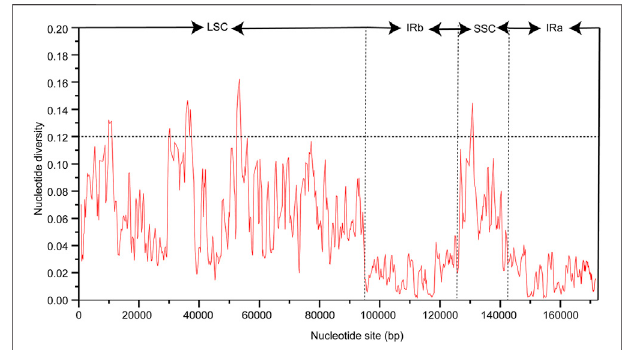
FIGURE 5 | Nucleotide diversity (Pi) among cp genomes of six Polygonum species.